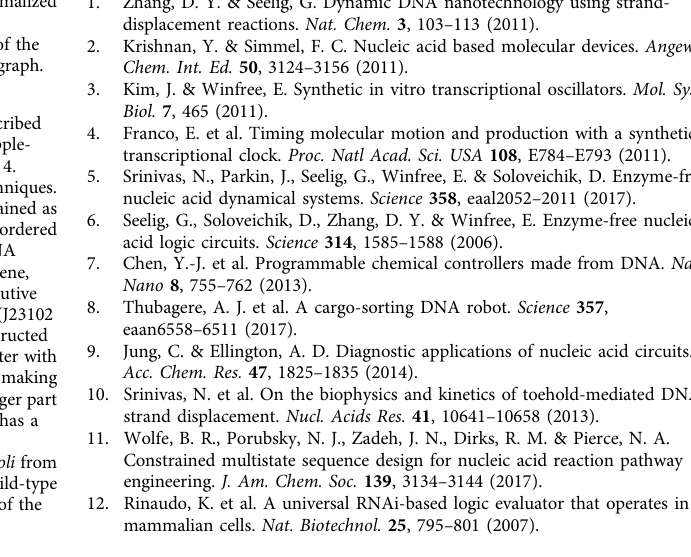
table. The gel slice was then puri fi ed using a ZR small-RNA PAGE Recovery kit (Zymo Research) according to the manufacturer ’ s instructions. For RNAs with no signi fi cant bands of incorrect length, the RNA was phenol-chloroform puri fi ed using Phase Lock Gel Heavy (VWR) tubes. One volume of Roti-Aqua-P/C/I (Carl Roth) was mixed with the transcription reaction and the sample was centrifuged at 16,000 × g for 5 min. One volume of chloroform (Carl Roth) was added, the sample was mixed, and centrifuged at 16,000 × g for 5min. The supernatant was trans- ferred to a new tube, 0.1 volume of 3M sodium acetate and three volumes of 99.8% ethanol were added. The mixture was kept at − 80 °C for 1 h and centrifuged at 4°C and 16,000 × g for 15min. The supernatant was removed, 500 μ l of 70% ethanol were added, and the sample was centrifuged at 4 °C and 16,000 × g for 5min. The supernatant was removed, and the remaining liquid was evaporated. The pellet